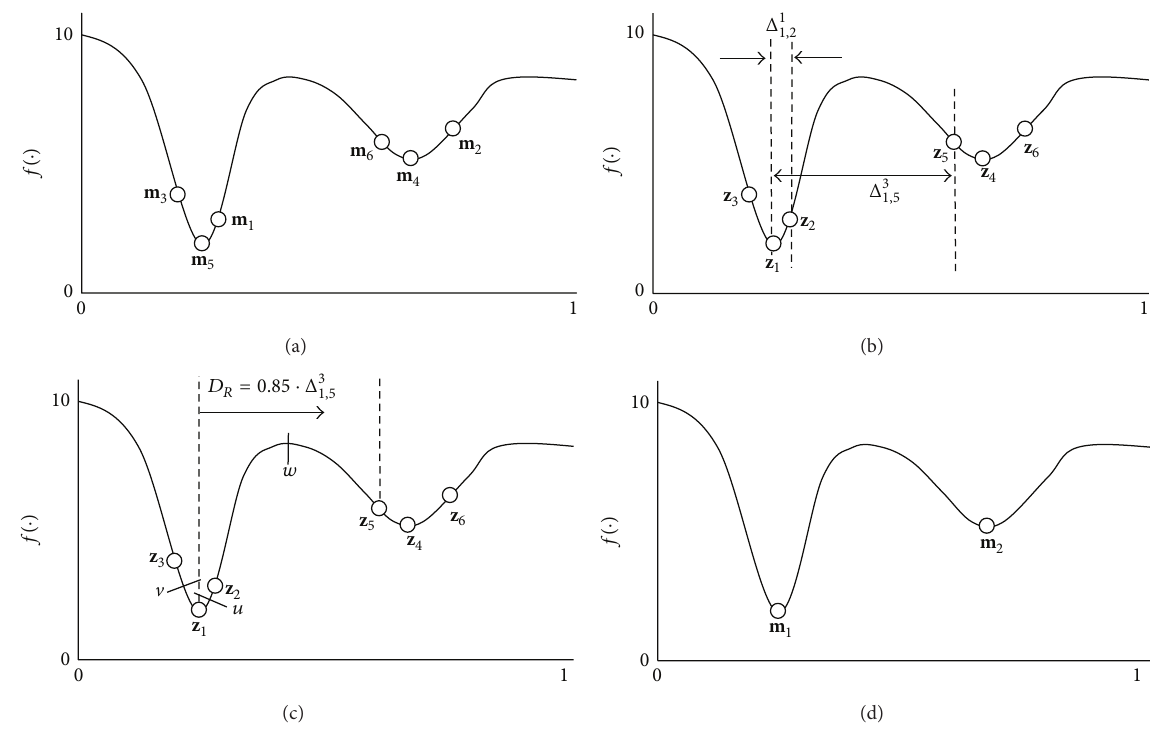
Figure 4: Depuration procedure. (a) Initial memory configuration, (b) vector Z and distances Δ 𝑎 1,𝑗 , (c) the determination of the depuration ratio 𝑅 , and (d) the final memory